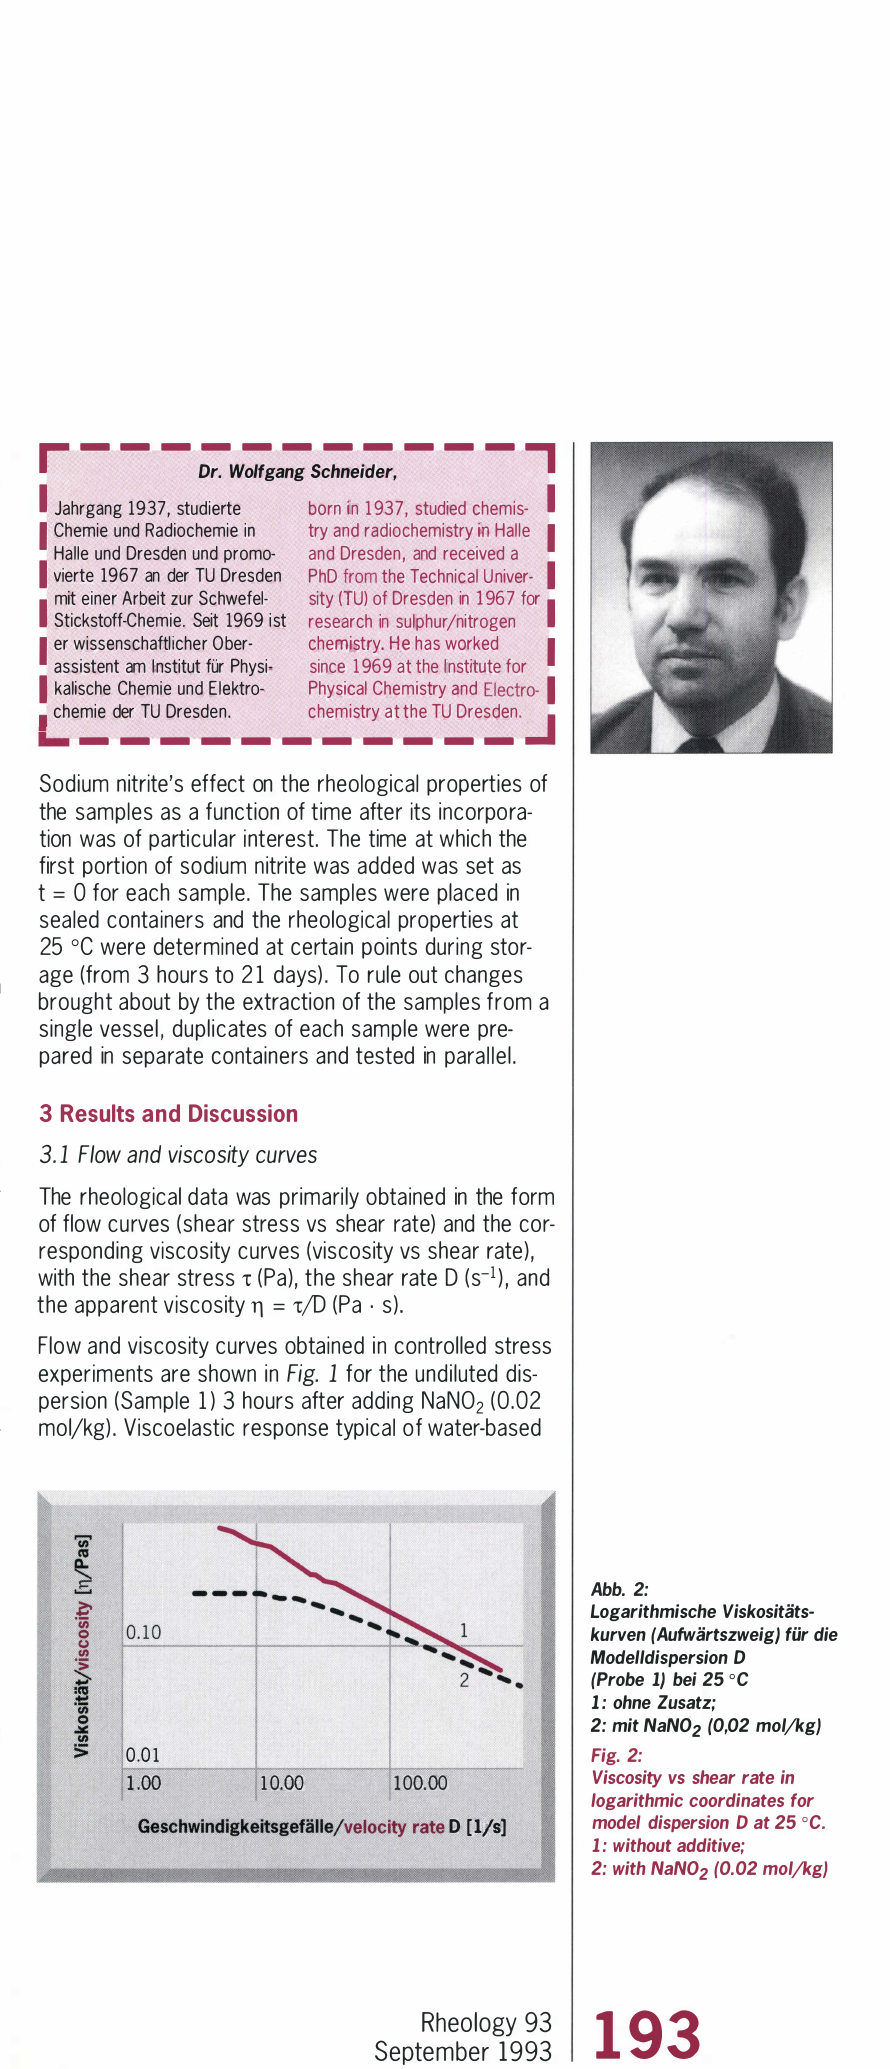
Fig. 2: Viscosity vs shear rate in logarithmic coordinates for model dispersion D at 25 o